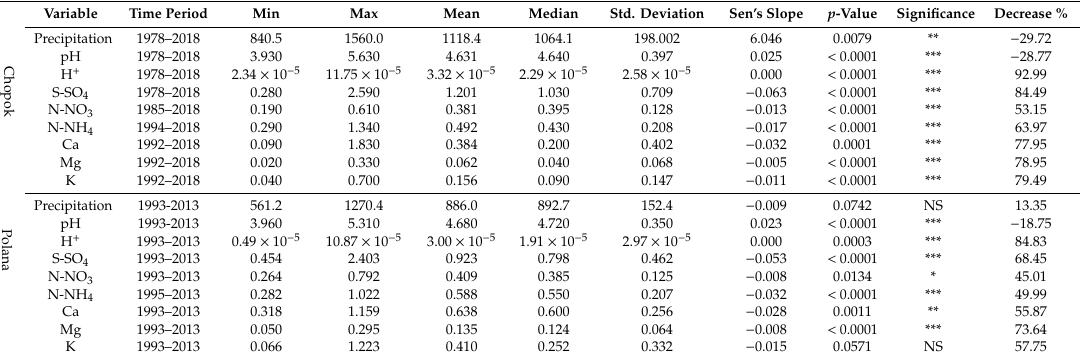
Table 2. Mann–Kendal test analyze and decrease of concentration elements in precipitation.